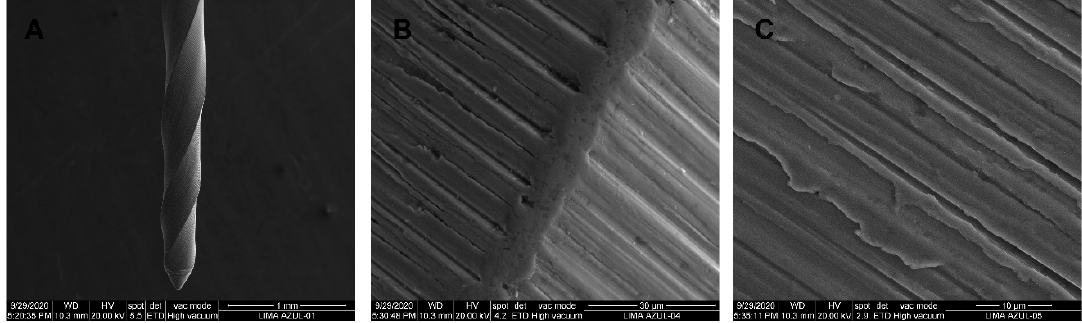
Figure 13. SEM images of CM-Blue Wire PVB endodontic rotary files at ( A ) 100×, ( B ) 3600×, and ( C ) 6500×.